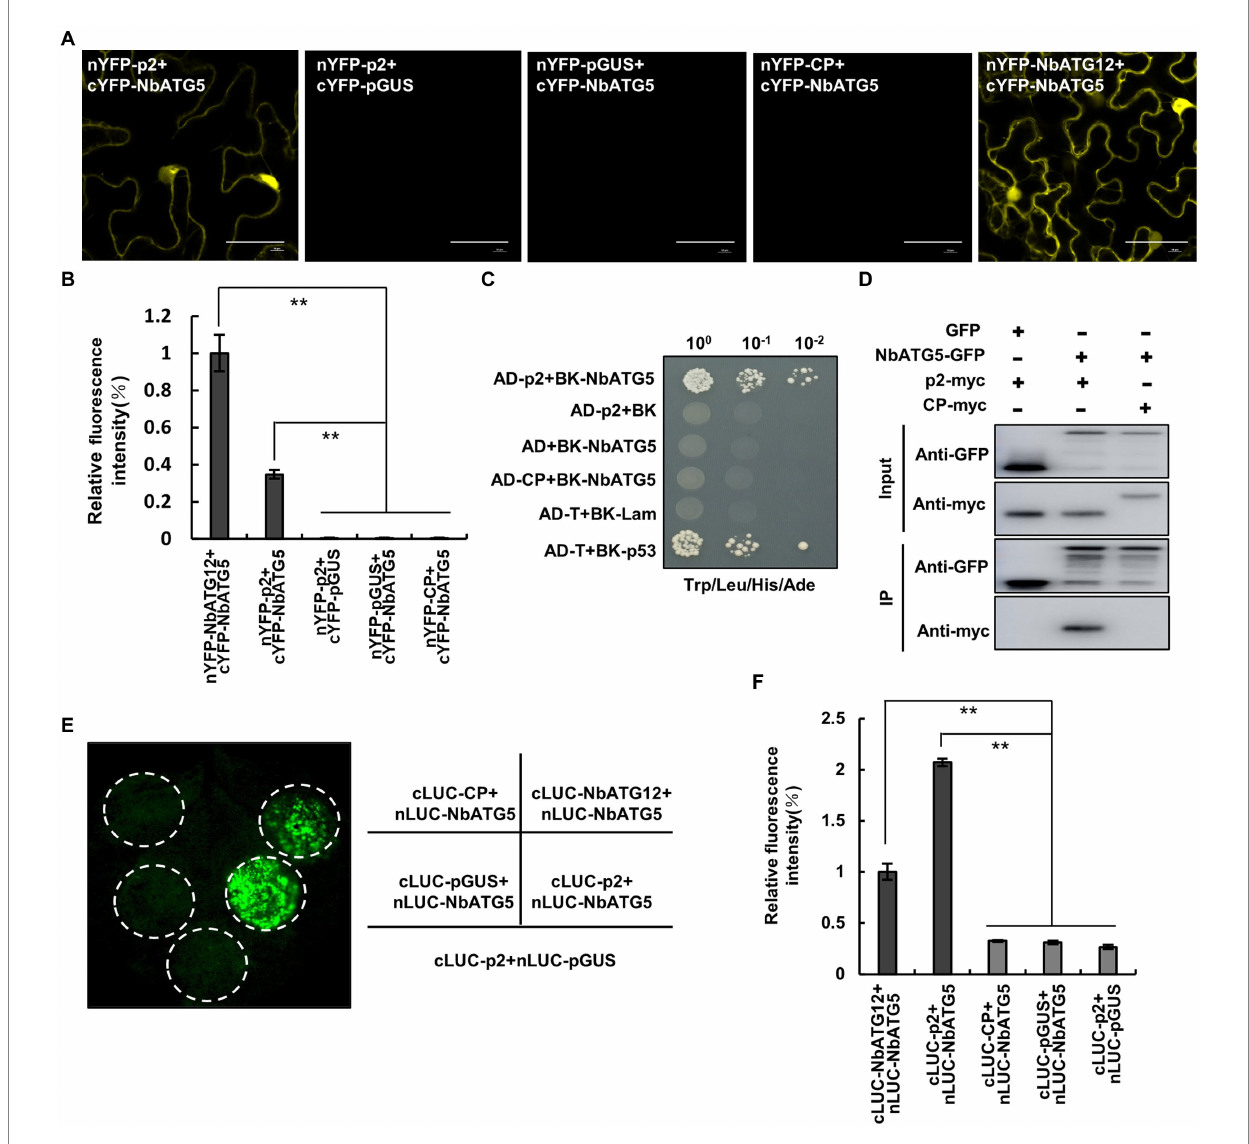
FIGURE 1 Nicotiana benthamiana ATG5 (NbATG5) interacts with RSV p2 protein. (A) Images from confocal microscopy showing the BiFC assay for interaction between NbATG5 and RSV p2. Cells were expressing nYFP-p2 and cYFP-NbATG5, and in the controls nYFP-GUS and cYFP-NbATG5, nYFP-p2 and cYFP-GUS, or nYFP-CP and cYFP-NbATG5. nYFP-NbATG12 and cYFP-NbATG5 were expressed in cells as positive controls. Bars, 20 μ m. (B) Analysis of the intensity of fluorescence in BiFC assay. Bars indicate standard error from three individual experiments. The asterisks indicate significant difference by Student’s t test (** p < 0.01). (C) NbATG5 interacts with RSV p2 protein in a yeast two hybrid (Y2H) assay. Yeast co-transformed with pGAD-T (AD-T) and pGBK-p53 (BK-p53) served as a positive control, and yeast co-transformed with vectors AD-T and pGBK-Lam (BK-Lam), pGAD-p2 (AD-p2) and BK-Lam or AD-T and pGBK-NbATG5 (BK-NbATG5) were the negative controls. Serial 10-fold dilutions of co-transformed yeast cells on synthetic defined (SD) medium ( − Ade/–His/ − Leu/ − Trp) with X-gal are shown. (D) Co-IP analysis of the interaction between NbATG5 and p2. NbATG5-GFP,